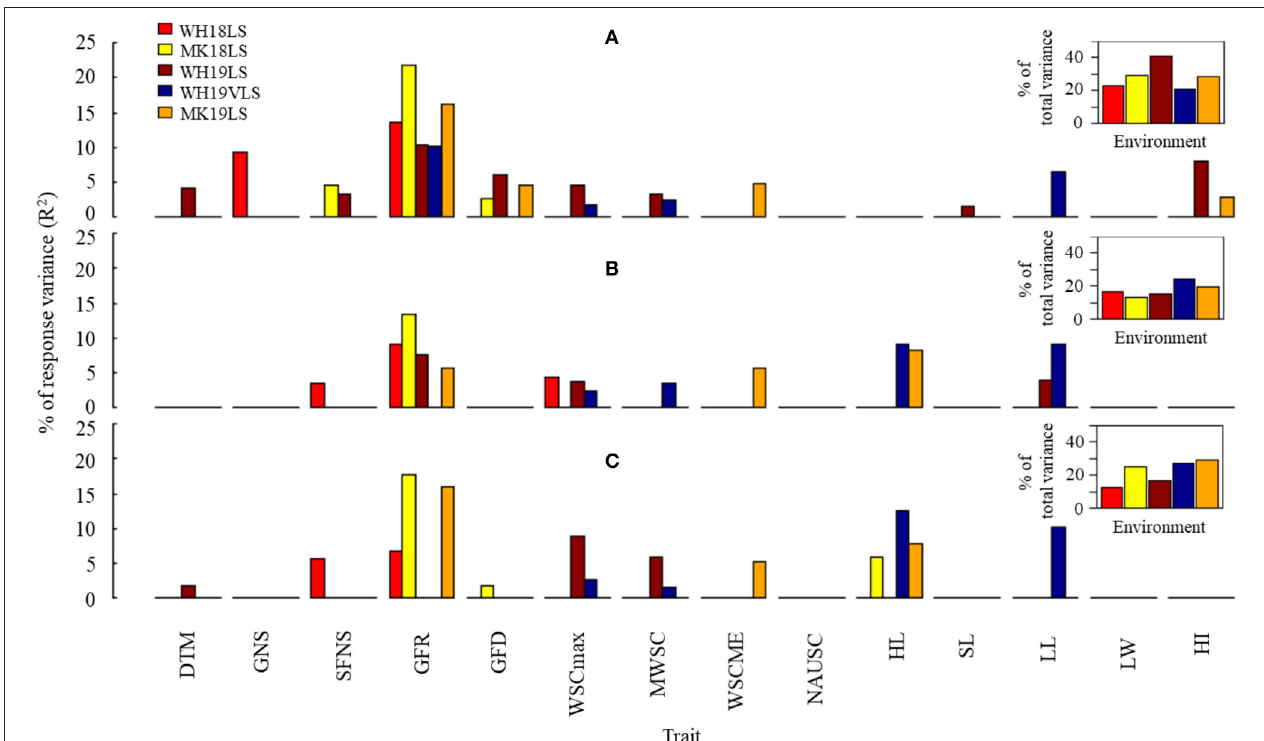
FIGURE 5 | Estimated contribution (% of the variance, R 2 ) of selected phenological, agro-morphological, and physiological traits to (A) thousand-grain weight heat tolerance (TGW.HTI), (B) grain plumpness heat tolerance (GP.HTI), and (C) retention heat tolerance (Ret.HTI) in WH18LS (light-red), MK18LS (yellow), WH19LS (dark-red), WH19VLS (navy-blue), and MK19LS (orange) environments. Insets show the total variability explained by the best significant model in each environment ( p < 0.001 ). Environment and trait definitions are as defined for Tables 1 , 2 ,